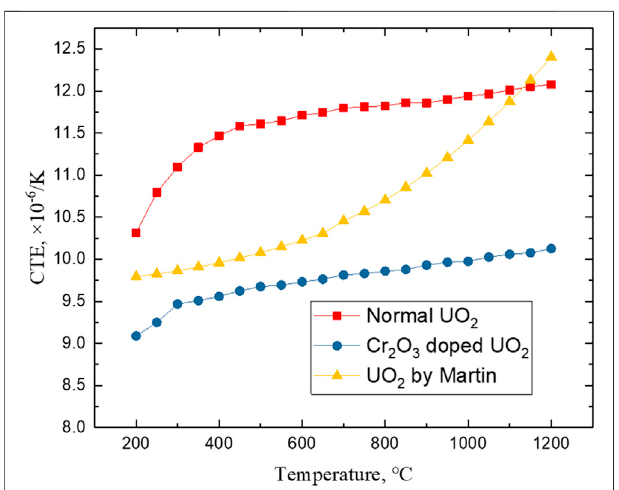
FIGURE 11 | The CTE of large grain UO 2 and normal UO 2